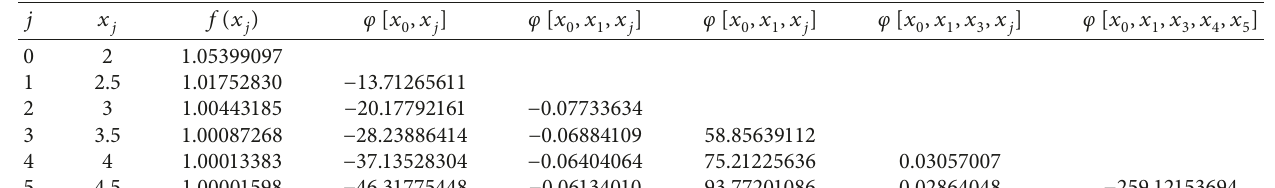
Table 5: Table of inverse differences.